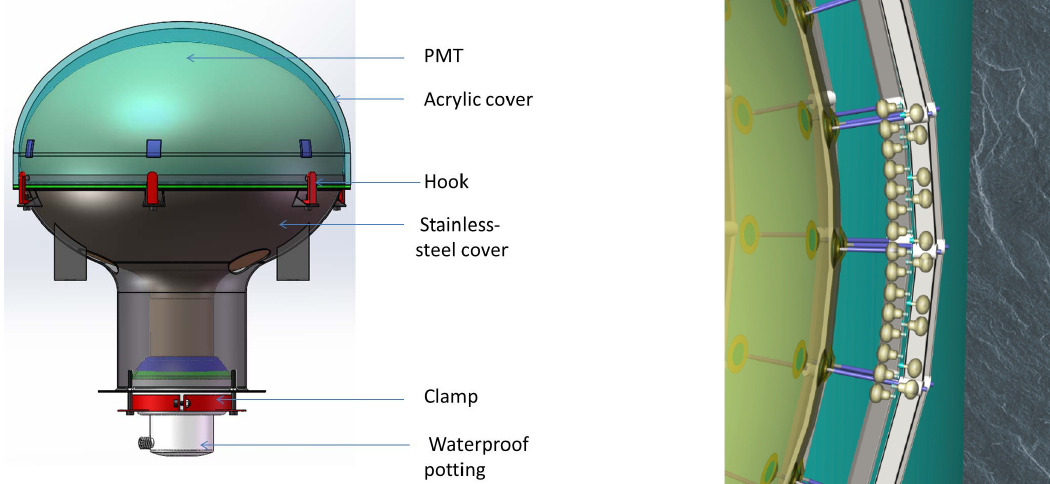
Figure 2. Left: schematics of an instrumented NNVT photomultiplier. Right: the acrylic vessel (yellow-green) anchored to the SS truss (light-gray) where the PMTs are installed and immersed in water (teal). The water pool (dark-gray — not drawn to scale) has a minimum thickness of 3.9 m from the acrylic vessel in order to provide a sufficient shielding against the radioactivity of the